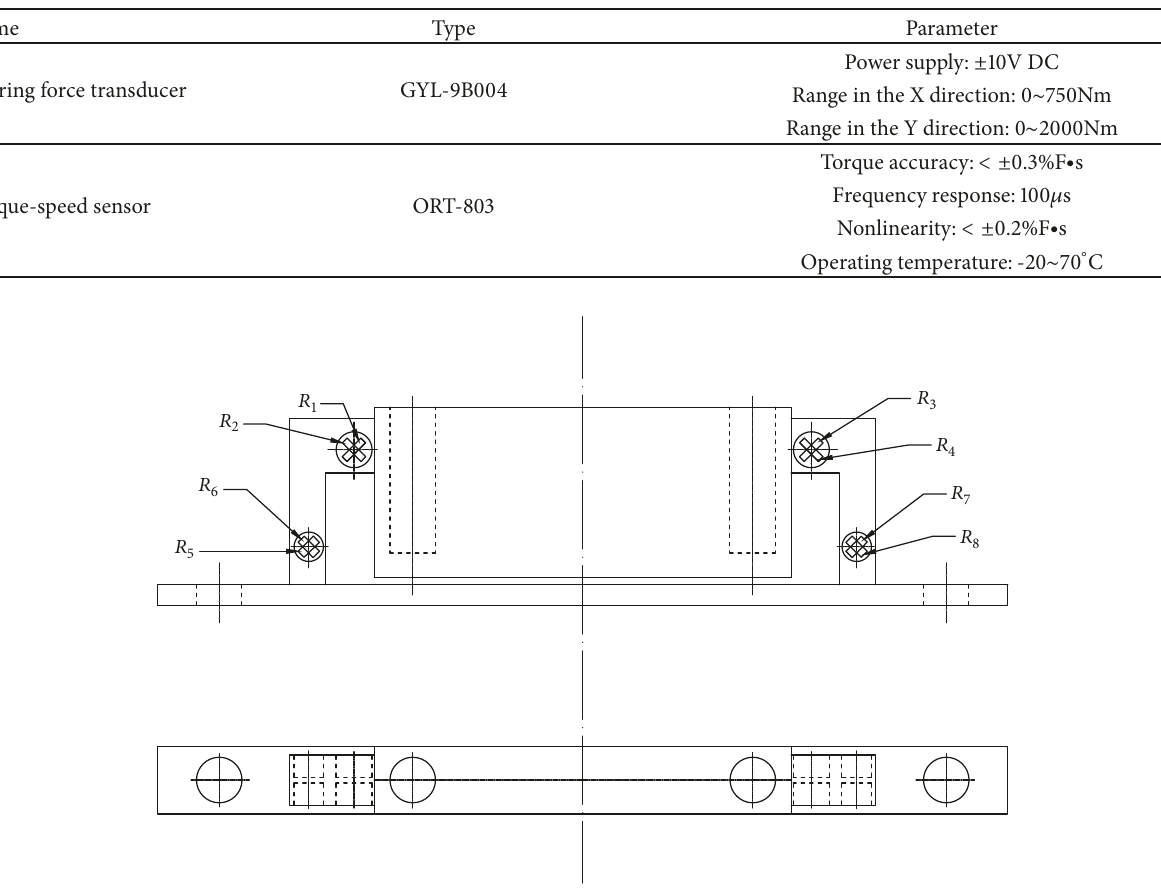
Table 2: Sensors details.